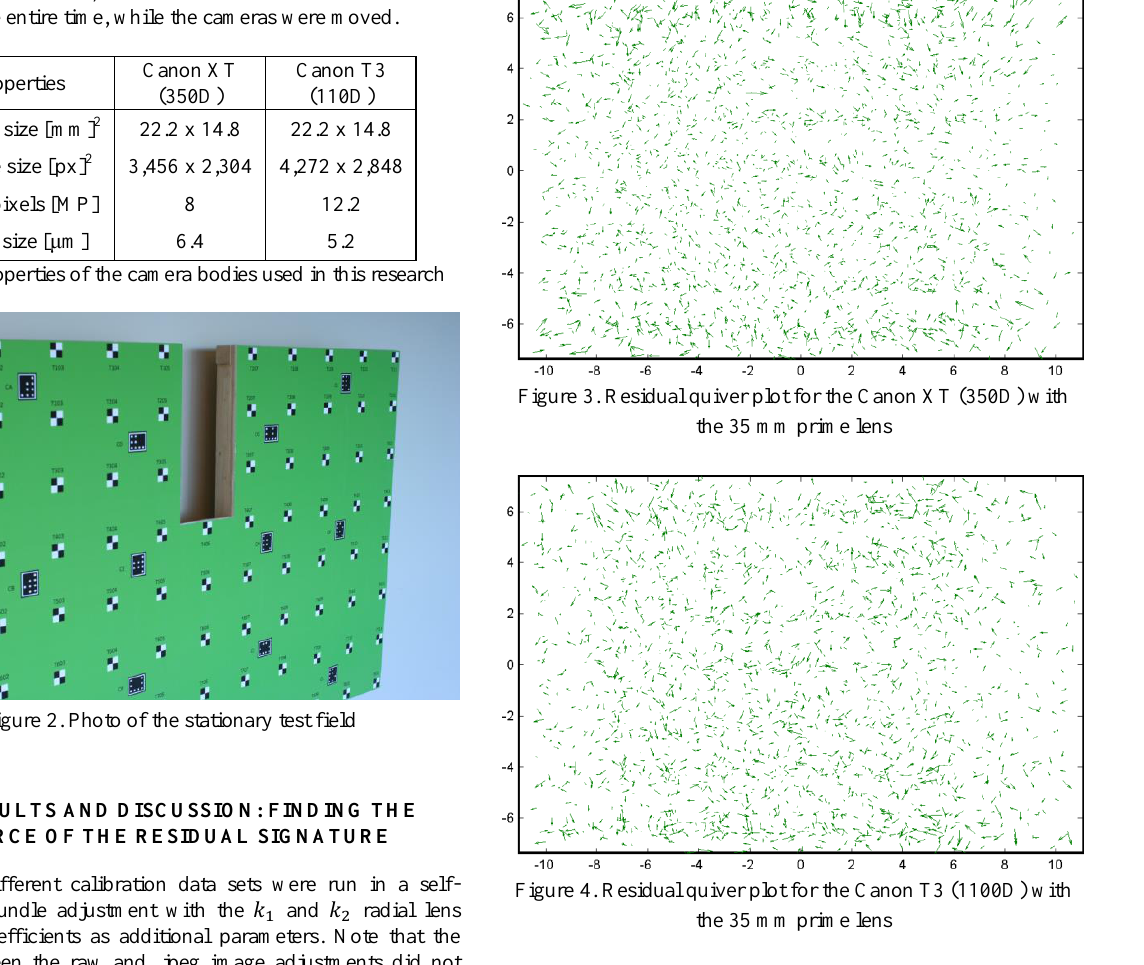
Figure 4. Residual quiver plot for the Canon T3 (1100D) with the 35 mm prime